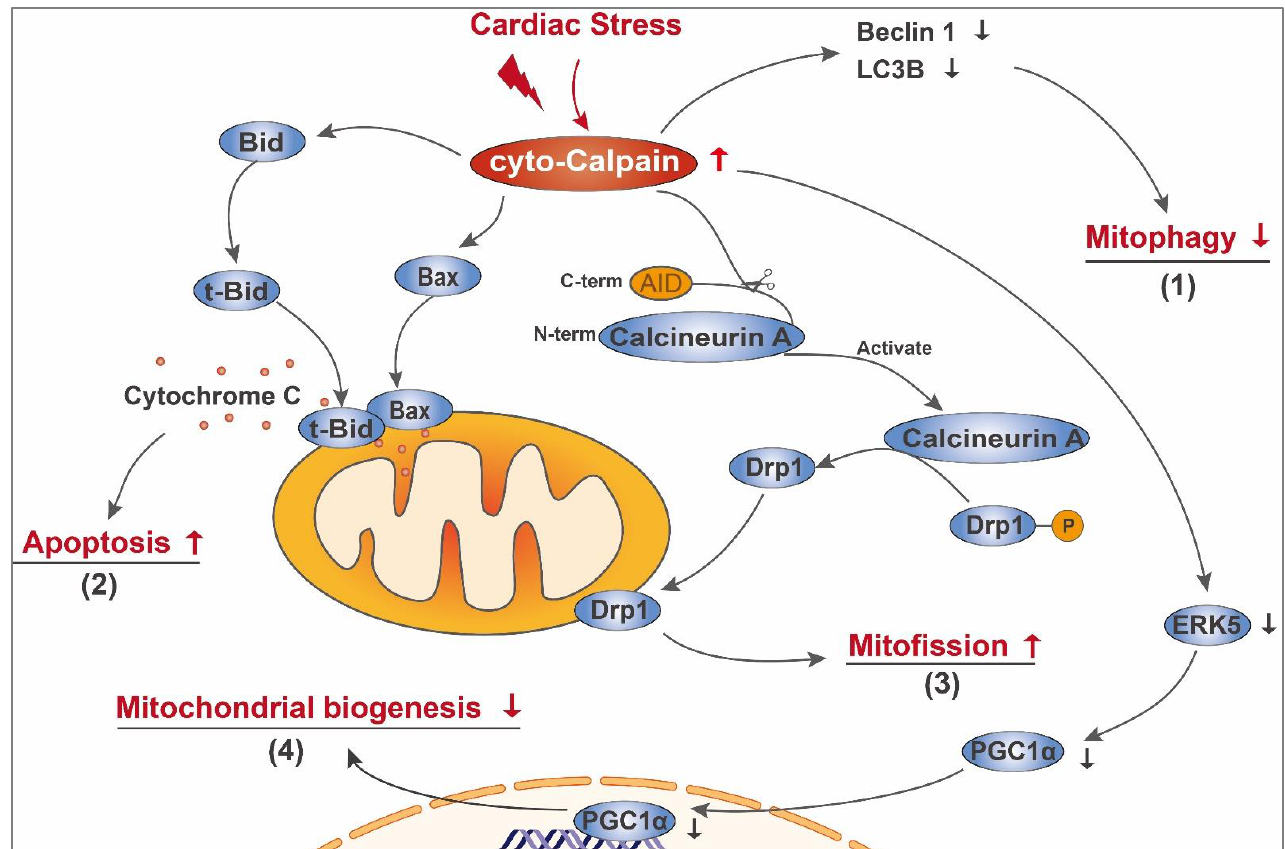
Figure 1. Schematic diagram of cyto-calpain-mediated mitochondrial damage in the diseased heart. In the diseased heart, cardiac stress leads to cyto-calpain activation. Activated cyto-calpain ( 1 ) decreases the content of Beclin 1 and LC3B, thus impairing mitophagy; ( 2 ) cleaves Bid and Bax, facilitating their mitochondrial translocation and subsequent leakage of pro- apoptotic components, such as cytochrome C; ( 3 ) activates calcineurin A by direct removal of its C-terminal autoinhibitory domain (AID), enabling calcineurin A to mediate the dephosphorylation of Drp1. The dephosphorylated Drp1 then transfers to mitochondria and mediates mitofission; ( 4 ) leads to ERK5 breakdown and subsequent downregulation of PGC-1 α , decreasing gene expression related to mitochondrial